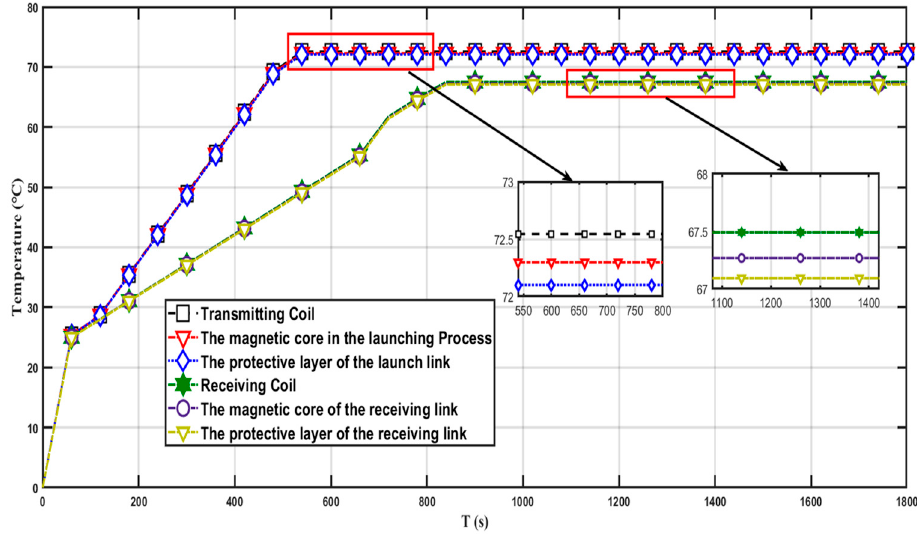
Figure 10. The temperature profile of the coil model with different